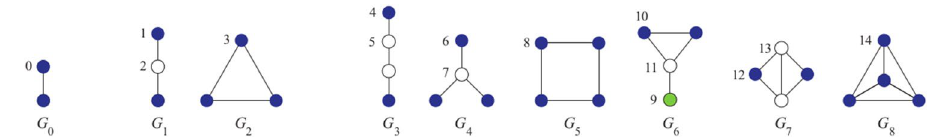
Figure 11. Graphlets up to 5 nodes with their relative